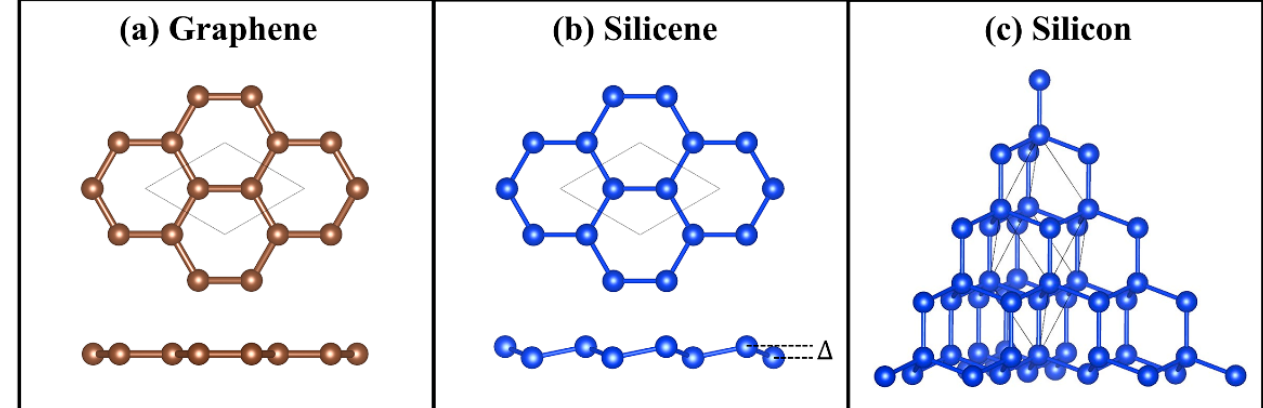
Figure 1. The atomic structure of ( a ) graphene, ( b ) silicene, and ( c ) bulk silicon. Graphene has an atomically flat surface, while the surface of silicene has a finite buckling height Δ .